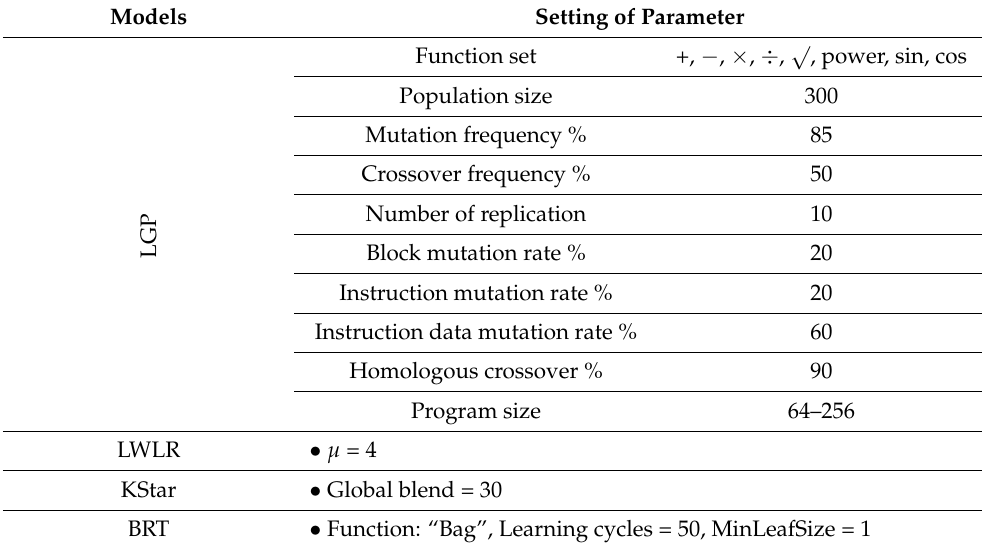
Table 3. The characteristics and setting parameters of proposed AI-based